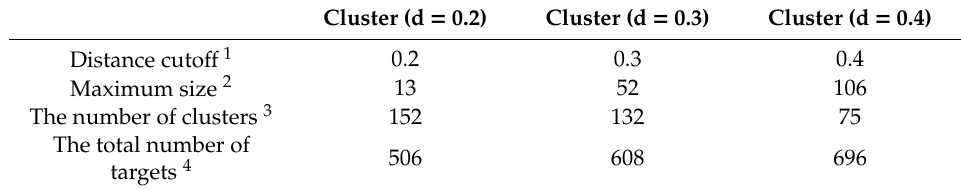
Table 1. The specification of target clusters with distance cuto ff (annotated as “d”).